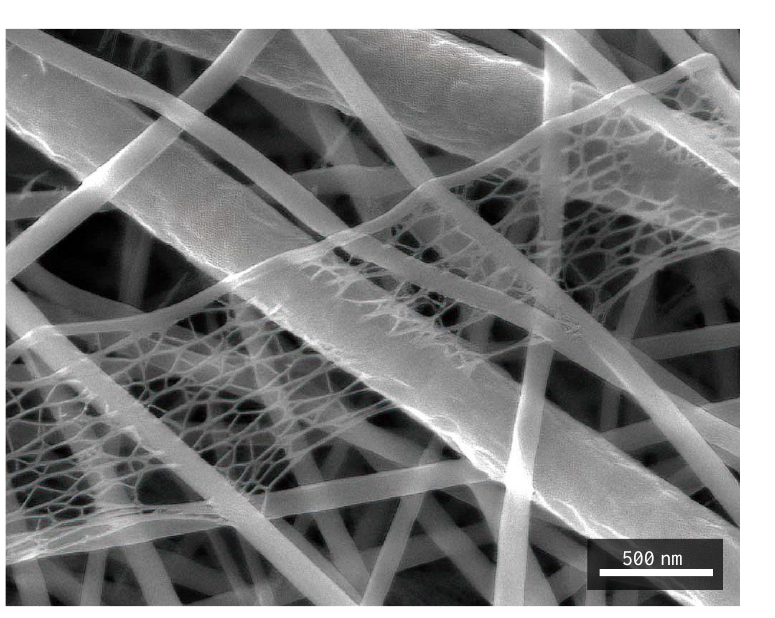
Figure 2. A structure of porous character resembling a cobweb. It is formed mainly with nylon. In this case, it is a sample in combination PVDF/PA6. Measurement parameters: acceleration voltage 5kV, magnification 80k ×